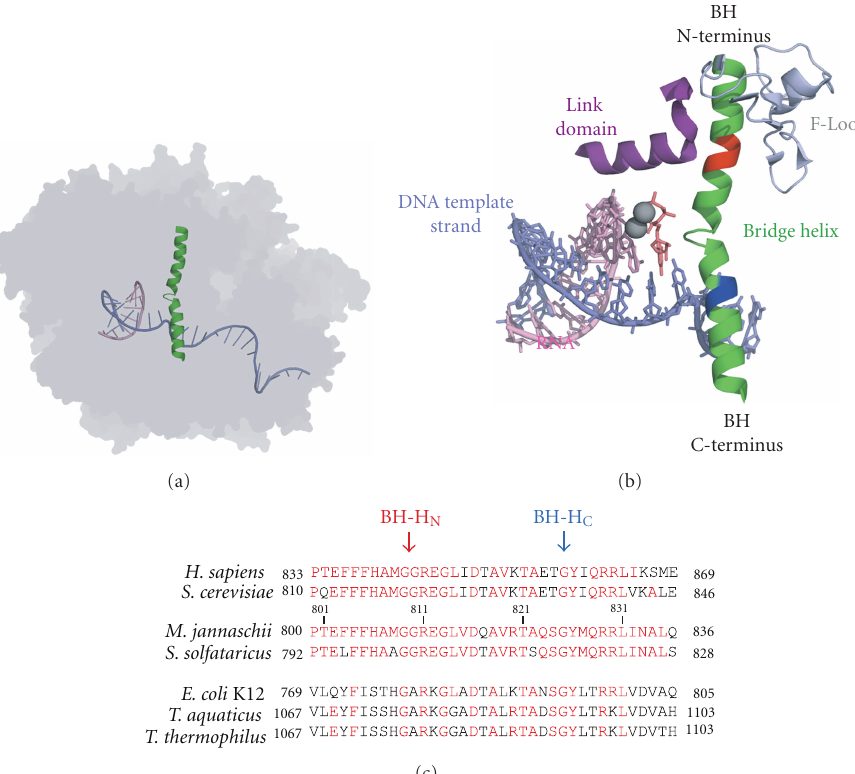
Figure 1: Structural aspects of the Bridge Helix. (a) Overall position of the Bridge Helix within RNAP. The Bridge Helix is shown as a green cartoon structure. Also shown are the DNA template strand (light blue) and the nascent transcript (pink). The remainder of the enzyme is shown as a transparent outline. Based on PDB# 2E2H [17] and visualized with PyMol [18]. (b) Detailed view of the Bridge Helix. The Bridge Helix is shown as a green cartoon structure, and the positions of the two molecular hinges are highlighted in red (BH-H N ) and blue (BH-H C ). Adjacent domains are shown in purple (Link Domain) or grey (F-Loop). The nucleic acid substrates are shown as stick models (DNA template strand, light blue; nascent transcript, pink; rNTP in insertion site, dark pink). The two grey spheres represent the magnesium ions (Metal-A and Metal-B) which represent the catalytic site. Based on PDB# 2E2H [17] and visualized with PyMol [18]. (c) Alignment of Bridge Helix sequences from eukaryotes ( Homo sapiens ; Saccharomyces cerevisiae ), archaea ( Methanocaldococcus jannaschii (euryarchaeota); Sulfolobus solfataricus (crenarchaeota)), and bacteria ( Escherichia coli , Thermus aquaticus , and Thermus thermophilus ). Residues that are identical to the reference organism used in the author’s laboratory ( M. jannaschii ) are shown in red. The numbers flanking the sequences show the position of the Bridge Helix within the intact open reading frame of the subunits. The approximate locations of the two molecular hinge regions, BH-H N and BH-H C , are indicated by